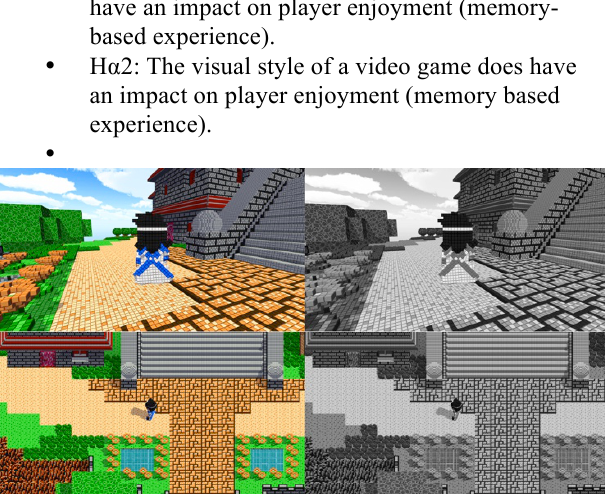
Figure 1. Screenshots from the game. From top left clockwise: Style A, Style B, Style C, and Style